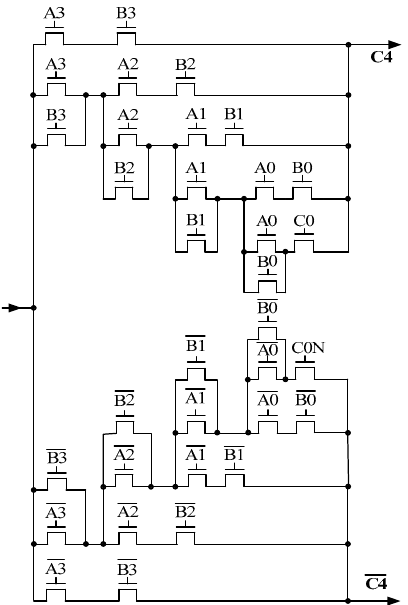
Figure 4. The pass transistor network (PTN) structure of the carry chain of the 4 bit adder block. The timing diagram of the bootstrapped SAPTL circuit is illustrated in Figure 5.